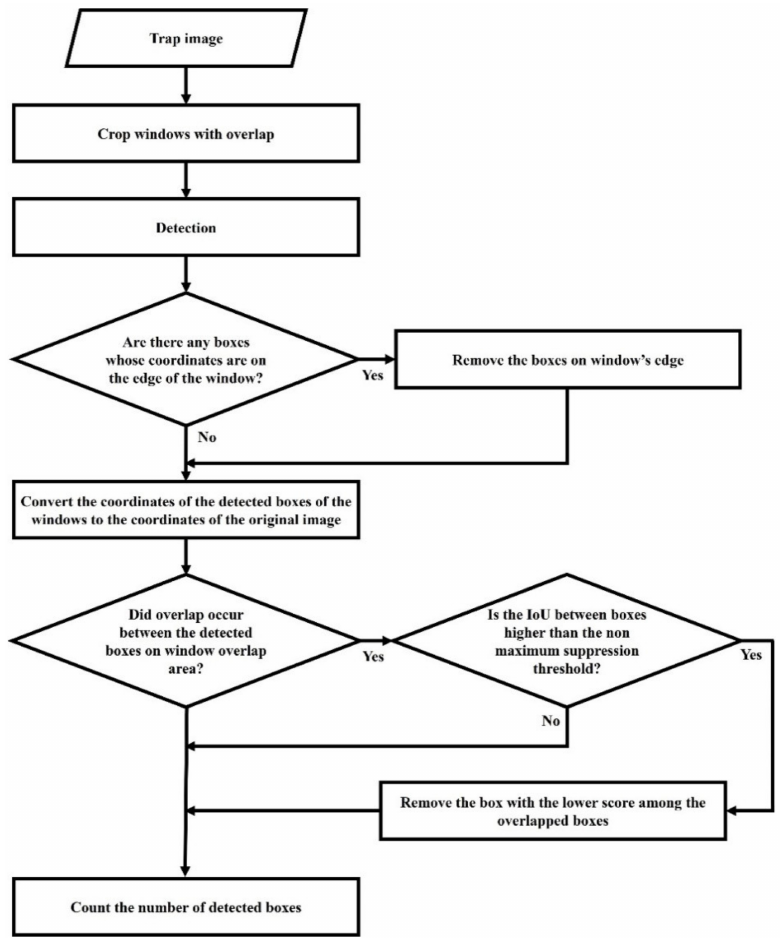
Figure 5. Flowchart for trap image